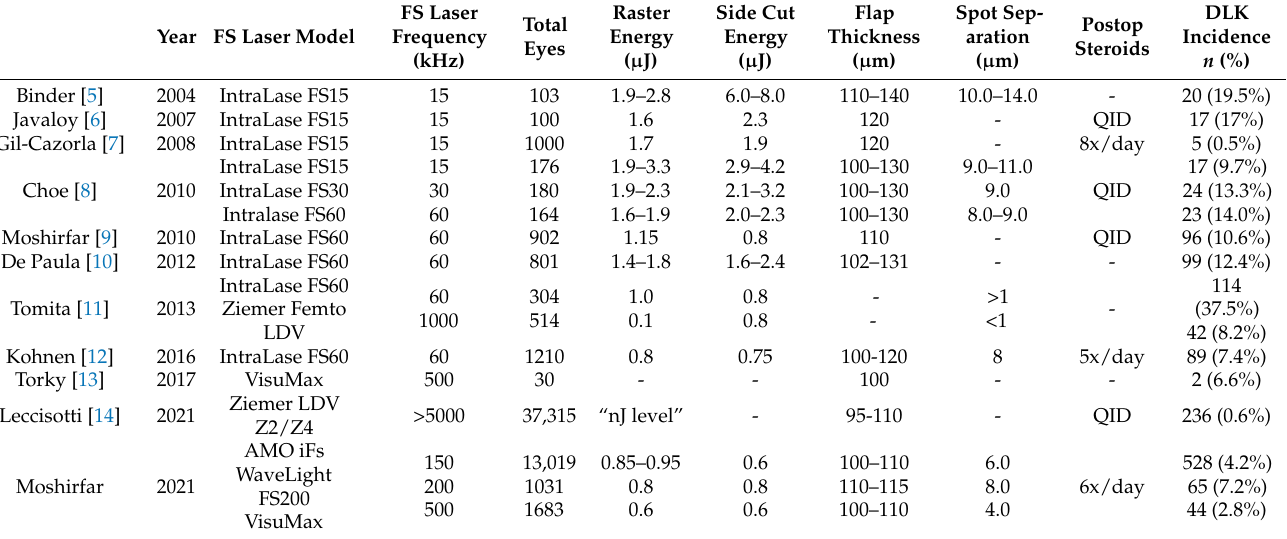
Table 5. Studies comparing DLK following femtosecond laser flap